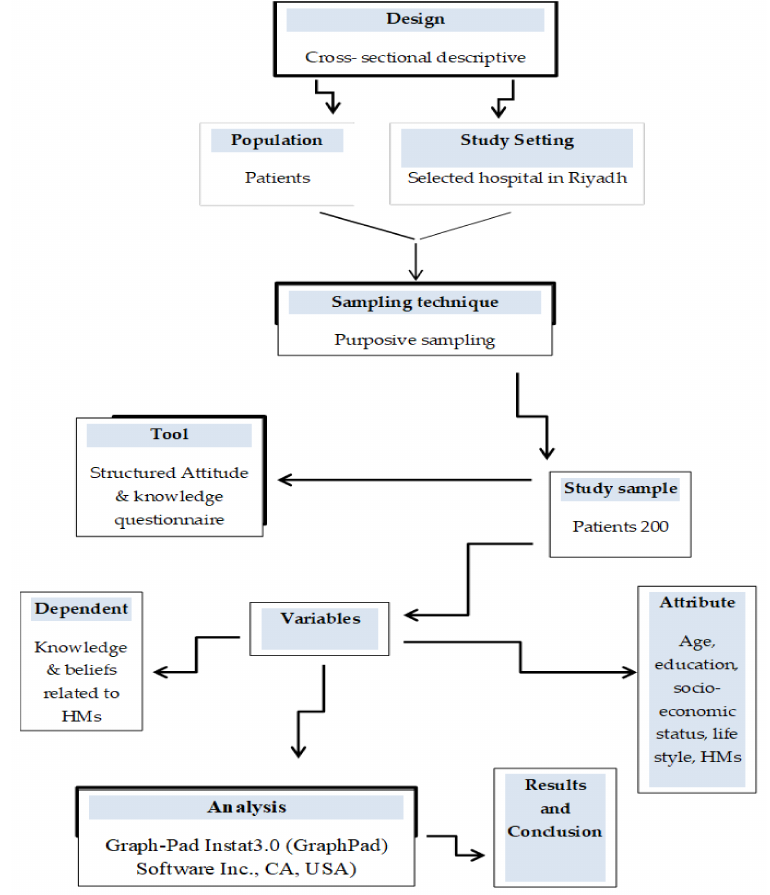
Scheme 1. An outline of the research